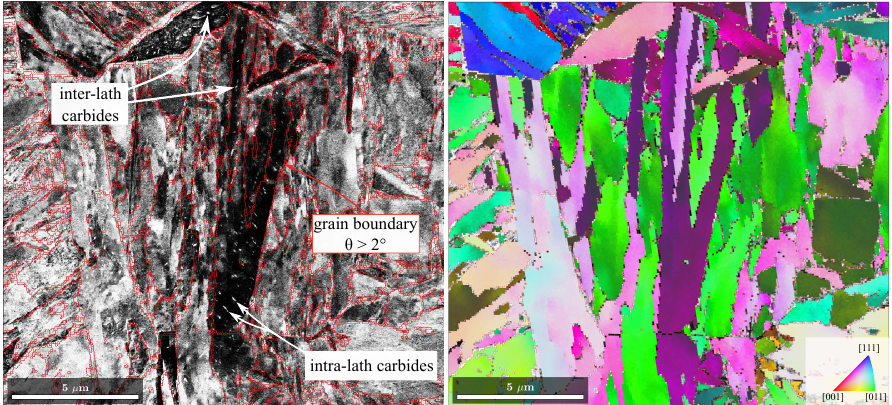
Figure 1. Cementite in a lower bainite of 22MnB5. Left: SEM image with the backscattered electron detector. Right: Orientation map on the same region, IPFcolor coded. The bainitic microstructure was formed after isothermally holding at 420 ◦ C for 12 s after austenization at 900 ◦